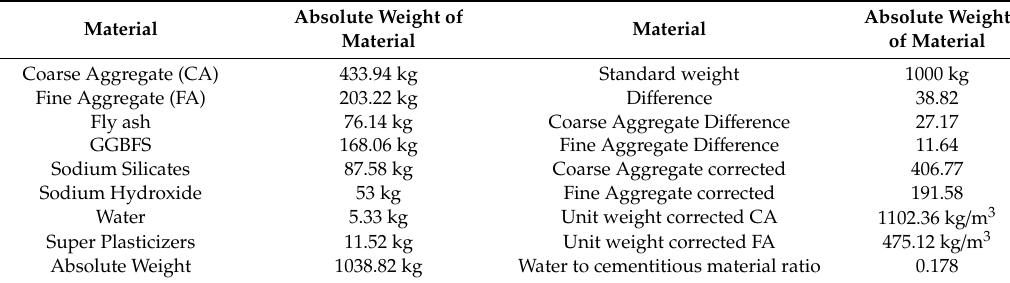
Table 6. Absolute unit weights and corrected unit weight of the